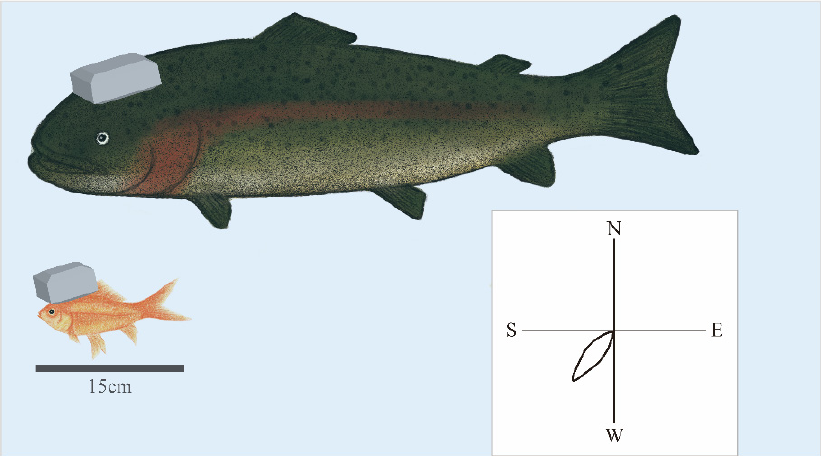
Figure 3. Neurologgers enable the examination of the neural correlate of underwater behaviors. The neurologger enclosed in the 3D printed custom-made waterproof case enables us to record neuronal activity from the telencephalon of freely swimming goldfish (bottom) and trout, salmonid fish (top) in the water. Head direction (HD) cells preferentially fire at a specific heading direction, as demonstrated in a polar plot of the HD tuning curve of an HD cell (bottom right). HD cells were found in the brain of goldfish and trout.